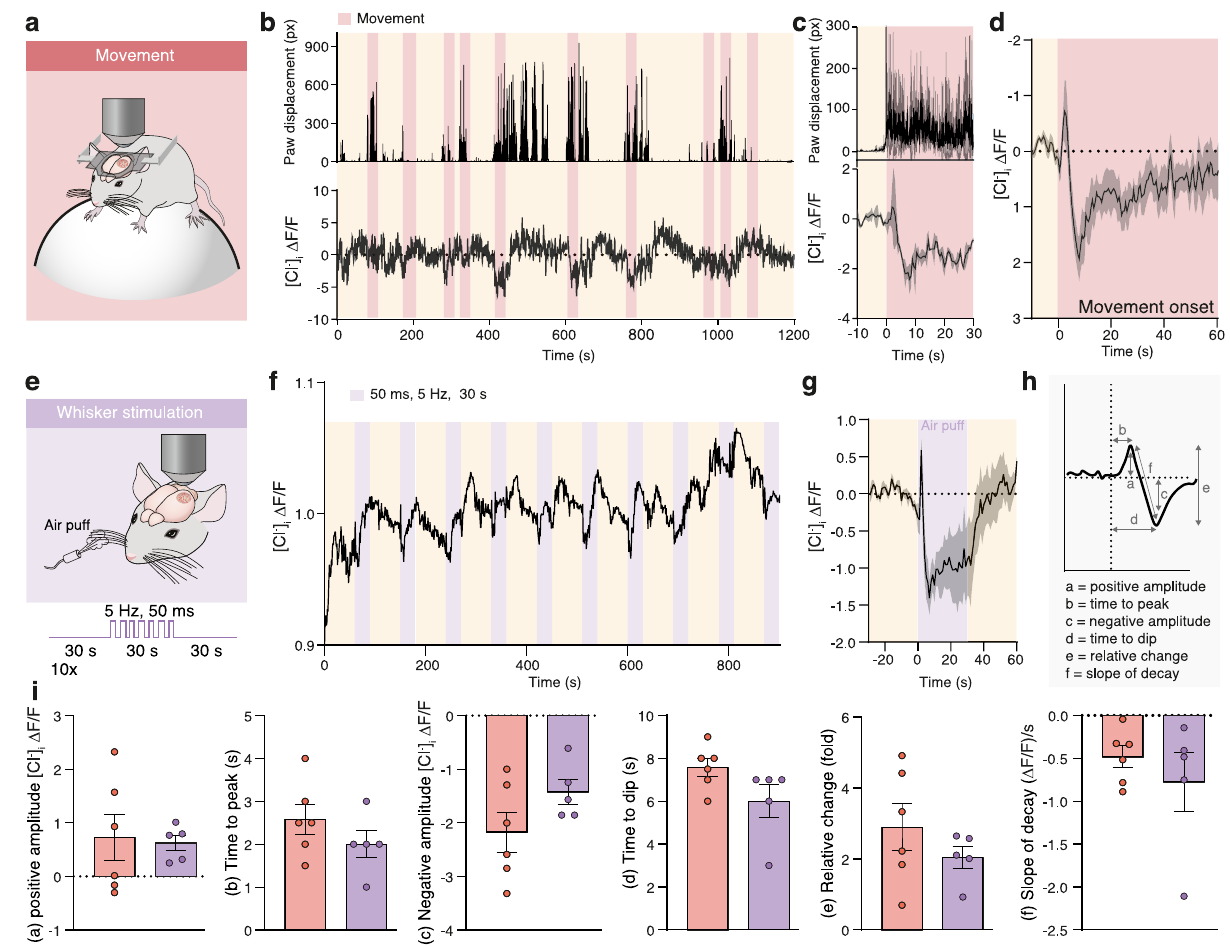
Fig. 2 | Astrocytic [Cl − ] i decreases upon movement and sensory stimulation. a Astrocytic [Cl − ] i was imaged using mClY and macroscopic imaging from soma- tosensory cortex of awake head- fi xed mice voluntarily running on a Styrofoam sphere. b Representativetracesoffrontpawdisplacement(top)andastrocytic[Cl − ] i (bottom). c Average of [Cl − ] i traces (bottom) of b during multiple running periods aligned to the running onset (top), data represent mean±SD. d Average [Cl − ] i trace duringmovementonset,shadingindicates±SEM( N =6mice). e Bulkastrocytic[Cl − ] i wasimagedinsomatosensorycortexofawakestationaryhead- fi xedmicesubjected